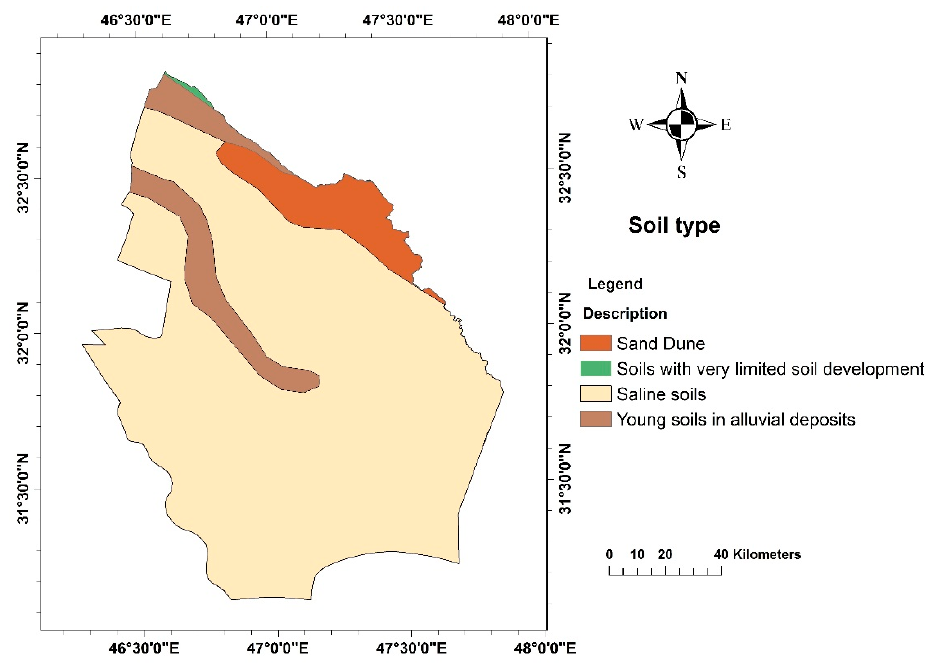
Figure 8. The roads raster using Euclidean distance function. ISPRS Int. J. Geo-Inf. 2020 , 9 , x FOR PEER REVIEW